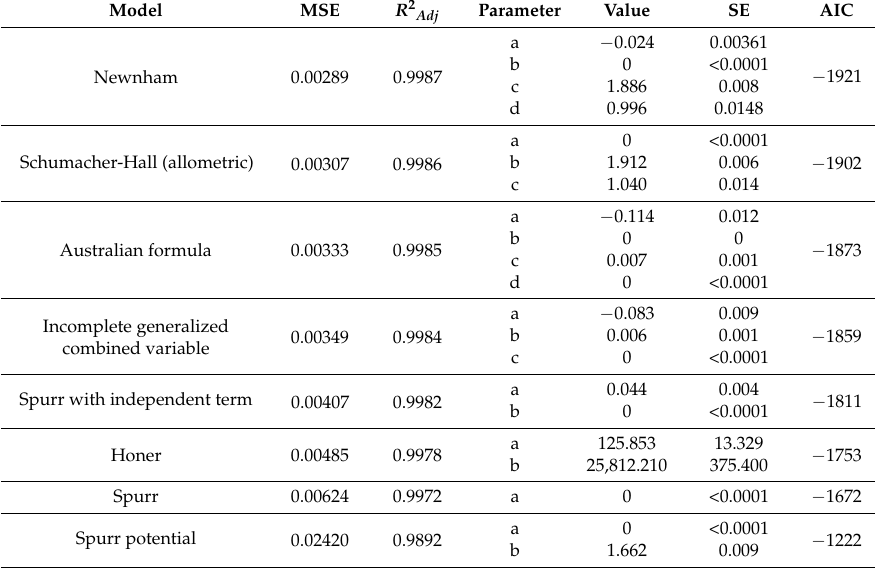
Table 4. Goodness of fit of the models developed for determining the volume of teak in living fences in the coastal lowlands of Ecuador.